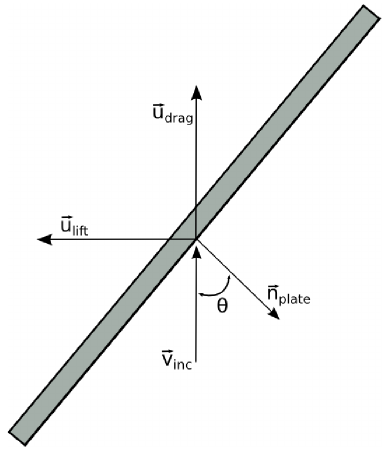
Fig. A1. Relation of the incident gas flow ( v inc ), the plate normal ( n i ), and the drag ( u drag ) and lift ( u lift ) unit